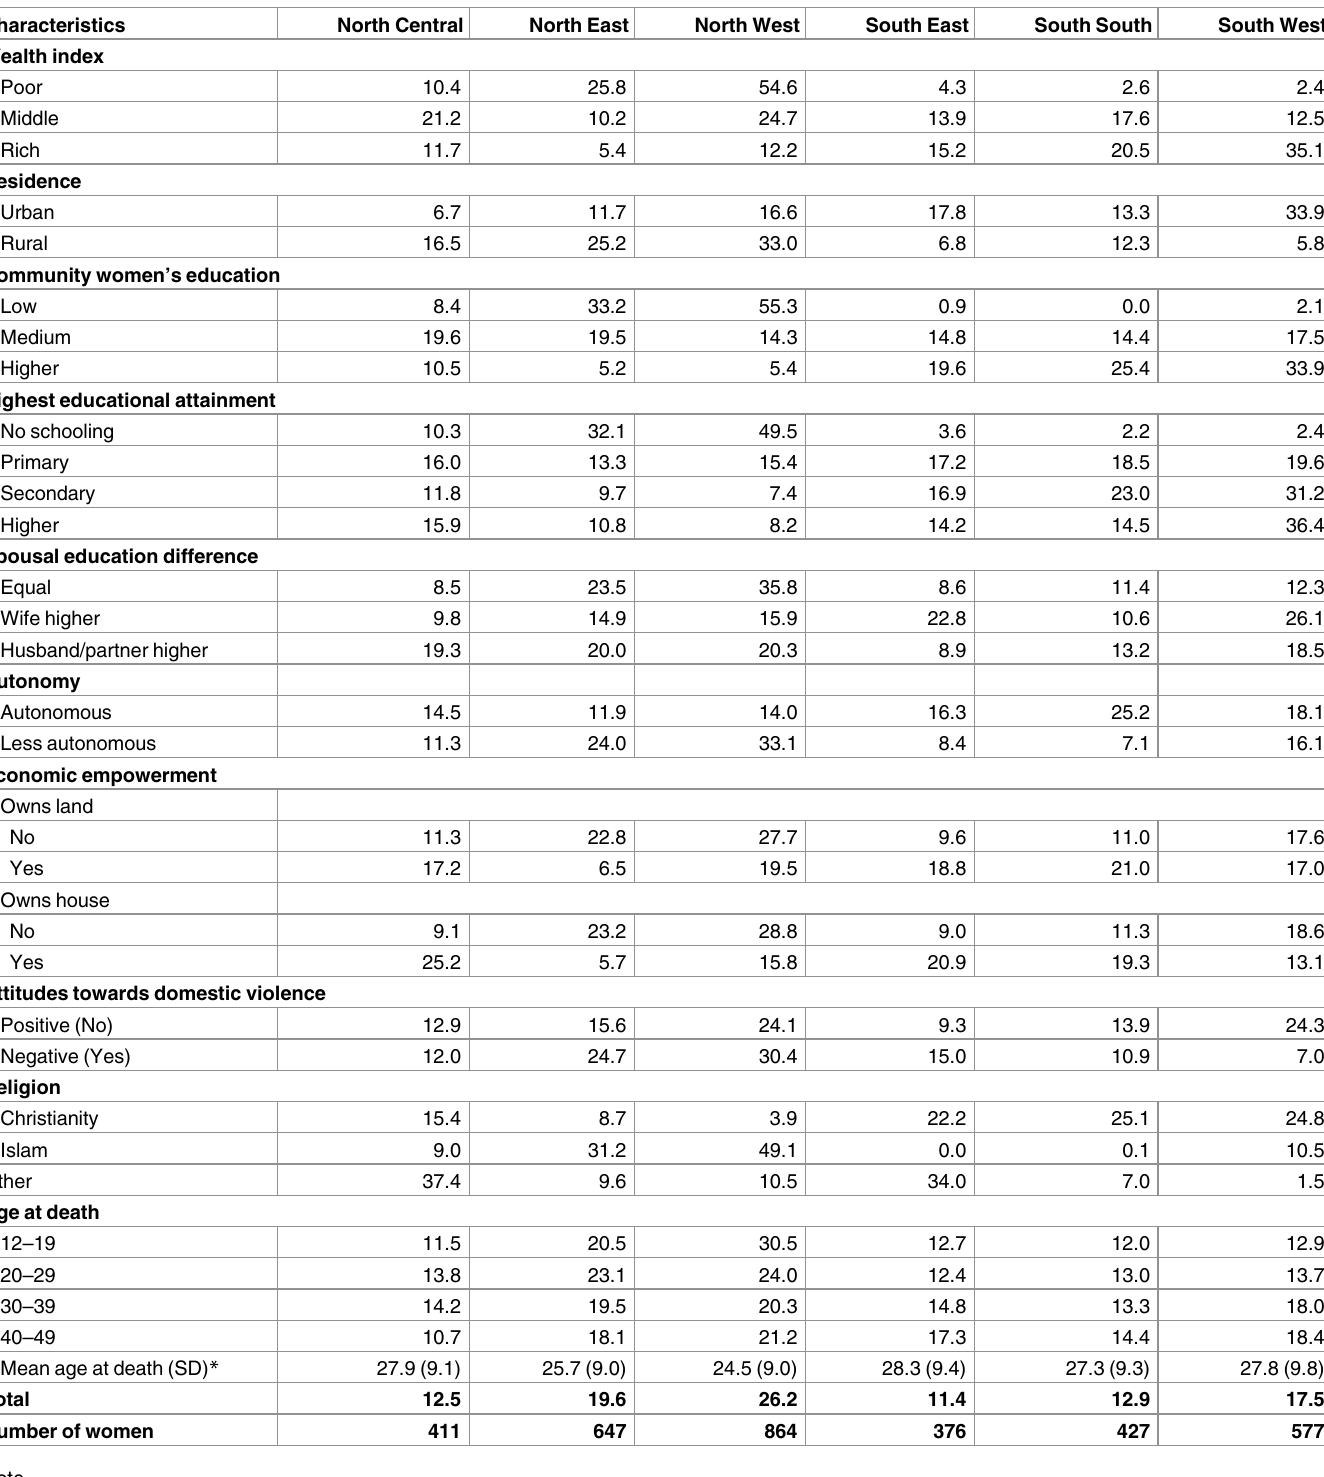
Table 4. Percent distribution of deceased sistersidentified by the direct sisterhood method by individual characteristics and region of residence, Nigeria Demographic and Health Survey 2013 (n = 3,302).